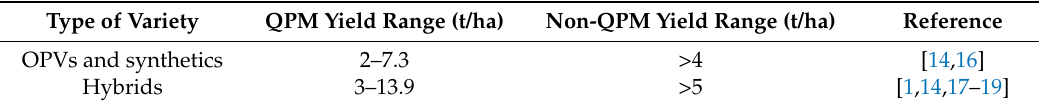
Table 1. Yield range of QPM and non-QPM